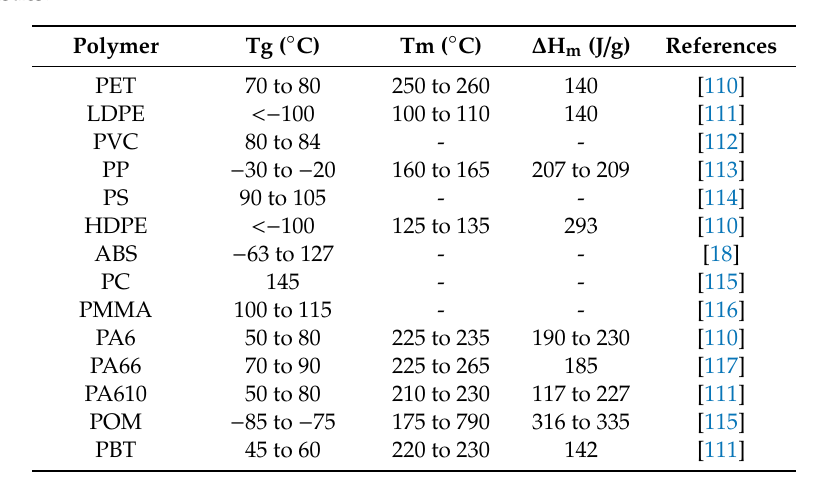
Table 6. Glass transition temperature (T g ), melt temperature (T m ), and melting enthalpy ( ∆ H m ) of the main